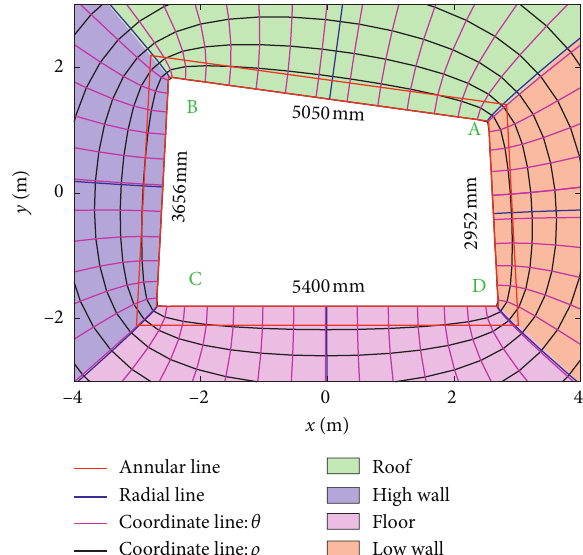
Figure 2: Schematic diagram of roadway